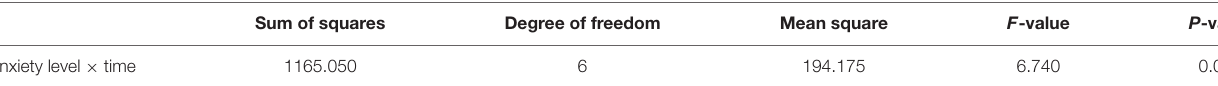
TABLE 6 | Interaction between anxiety level and time.